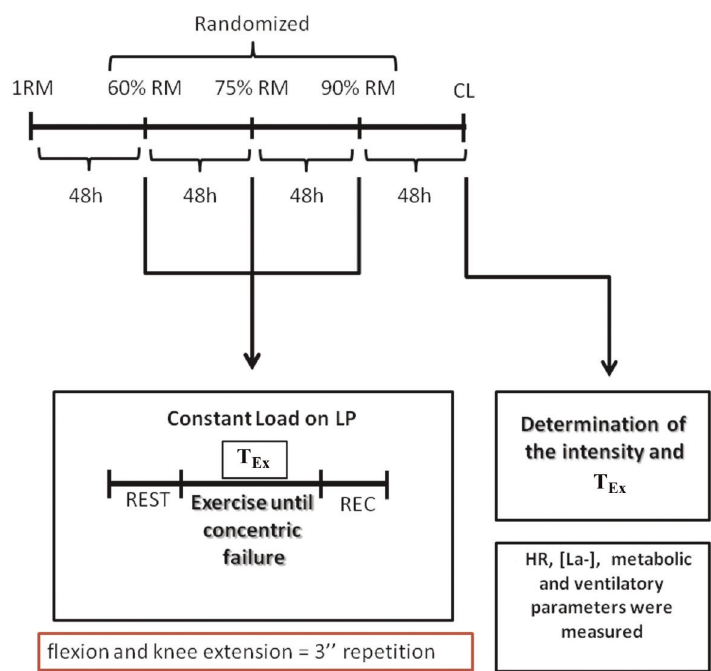
Figure 1. Flowchart of the study. RM: repetition maximum; REC: recovery; CL: critical load; LP: Leg press; T Ex : time to exhaustion; HR: heart rate; [La - ]: lactate.